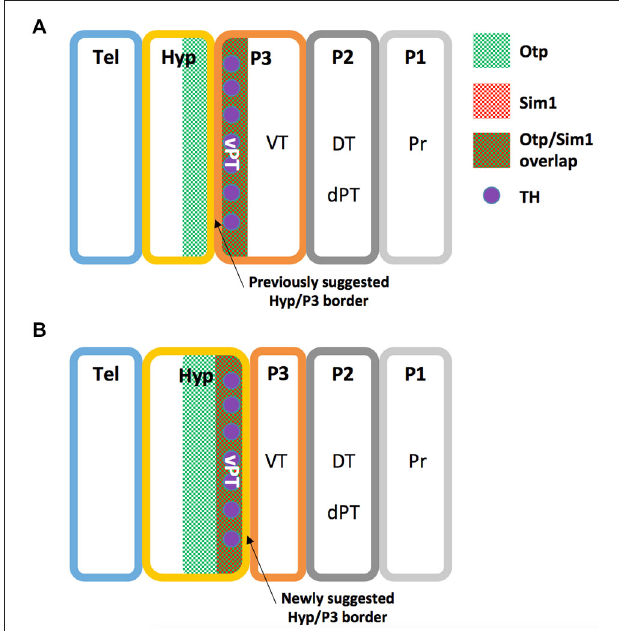
FIGURE 2 | Revised prosomere subdivision of the zebrafish forebrain . (A) The previously suggested zebrafish prosomeric model (see text). (B) The newly suggested zebrafish prosomeric model based on Otp and Sim1 expression patterns. In this model, the ventral boundary between the hypothalamus and prosomere 3 is shifted to the caudal limit of Sim1 and Otp domains, while the ventral posterior tuberculum (vPT), is included in the zebrafish hypothalamus. DT, dorsal thalamus; dPT, dorsal part of the posterior tuberculum; Hyp, hypothalamus; P1, prosomere 1; P2, prosomere 2; P3, prosomere 3; Pr, pretectum; Tel, telencephalon; TH, Tyrosine hydroxylase positive neurons; vPT, ventral part of the posterior tuberculum; VT, ventral